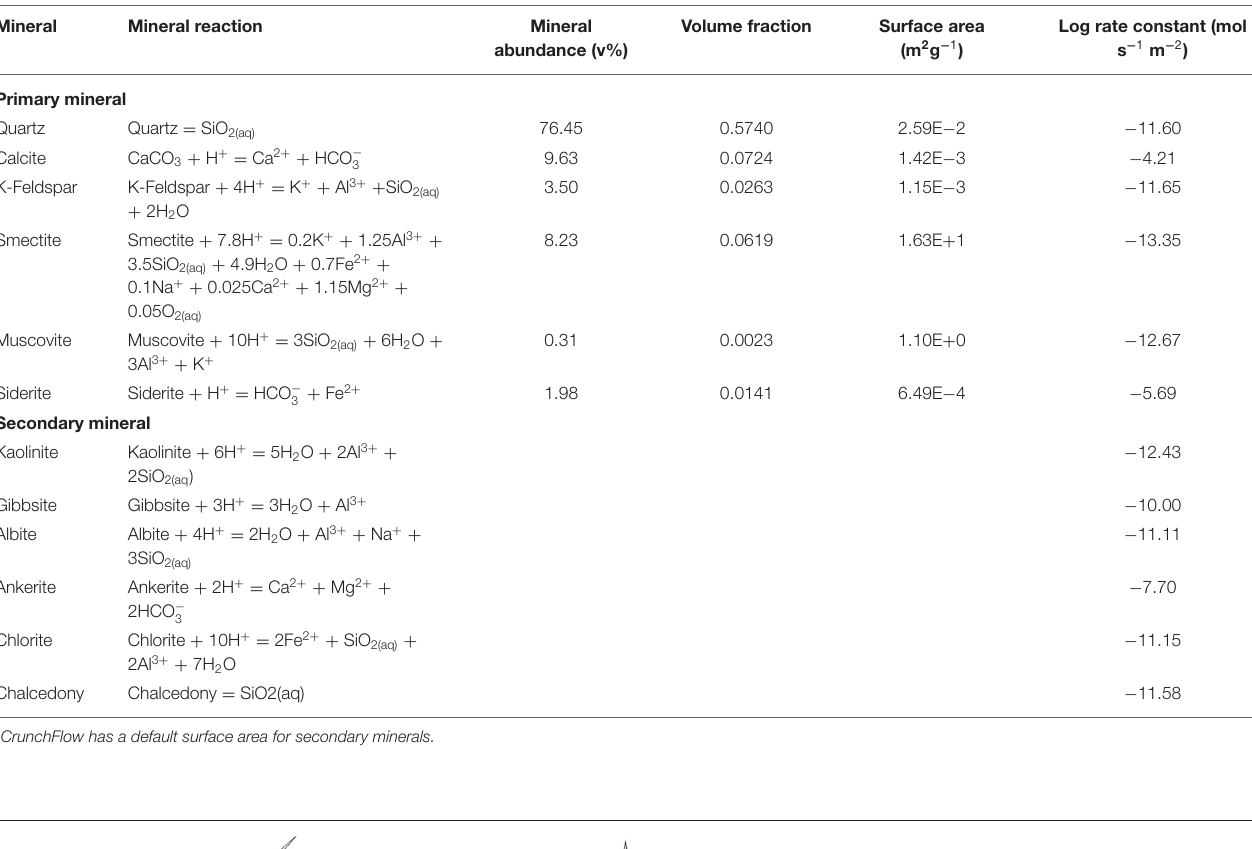
Frontiers in Water |